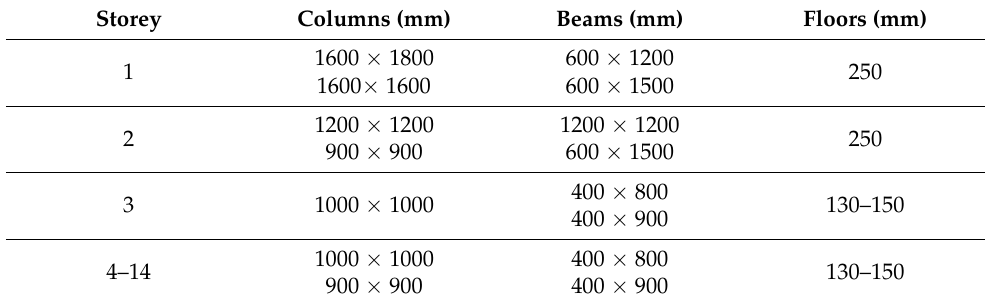
Table 1. Geometric dimensions of typical members of Building G1.